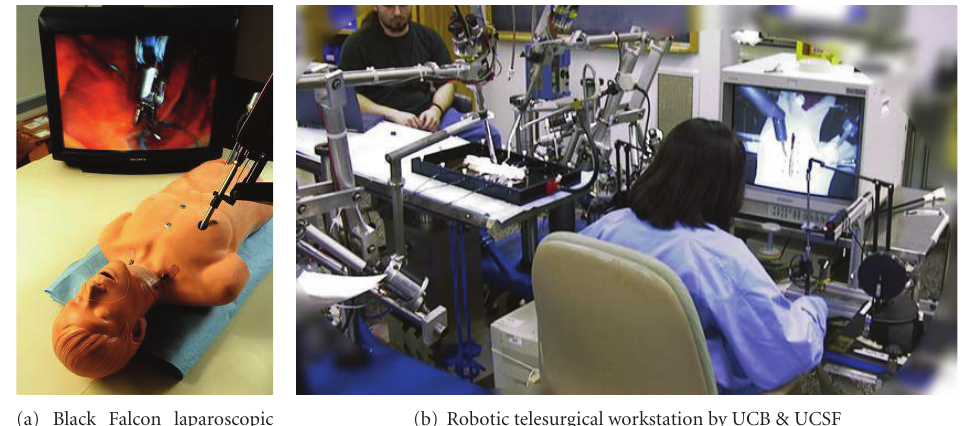
Figure 4: (a) Black Falcon robotic system developed at MIT for laparoscopic surgery [9]. (b) Laparoscopic telesurgical workstation jointly developed by the UC Berkeley and UC San Francisco [10]. Both systems aim to enhance the dexterity and sensation of minimally invasive surgery through using scaled robotic manipulators under the control of the